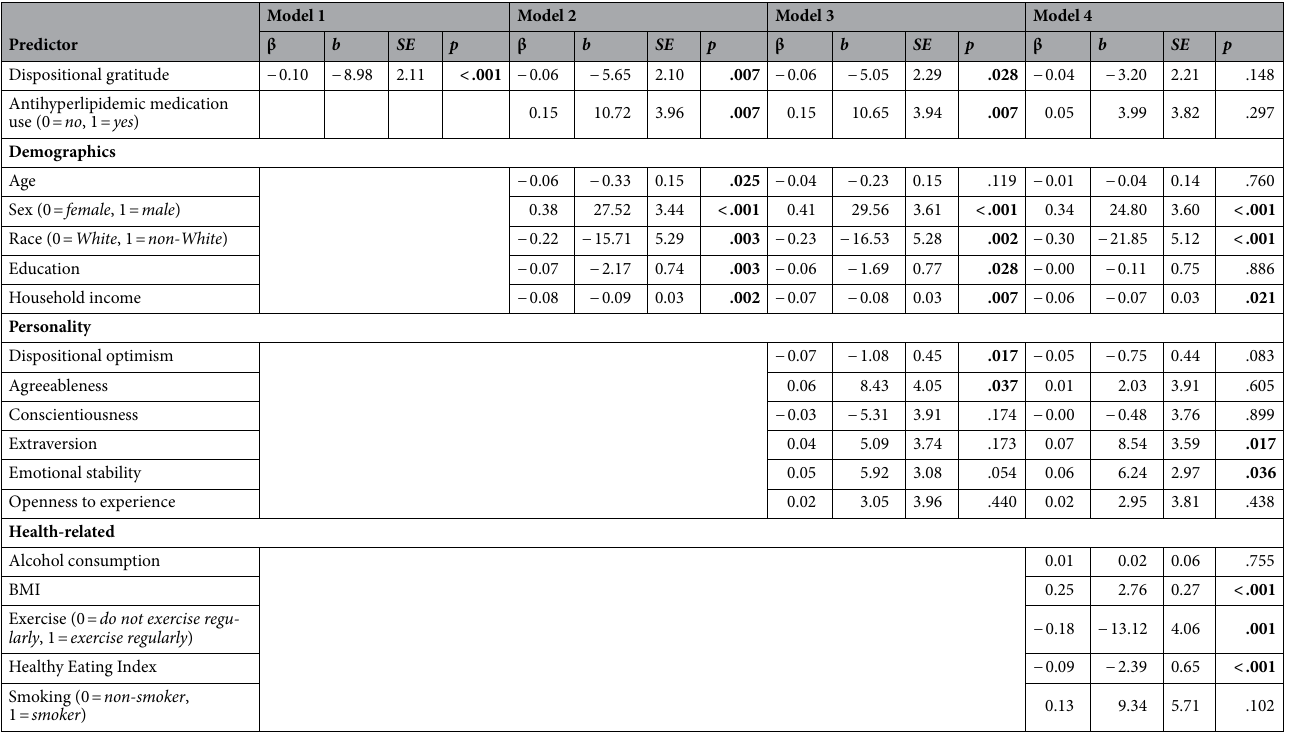
Table 4. Model summaries with triglycerides as the outcome variable. N = 1800. β = standardized slope coefficient, b = unstandardized slope coefficient, SE = standard error of the slope coefficient. Bolded p -values indicate statistical significance at the .05 level.